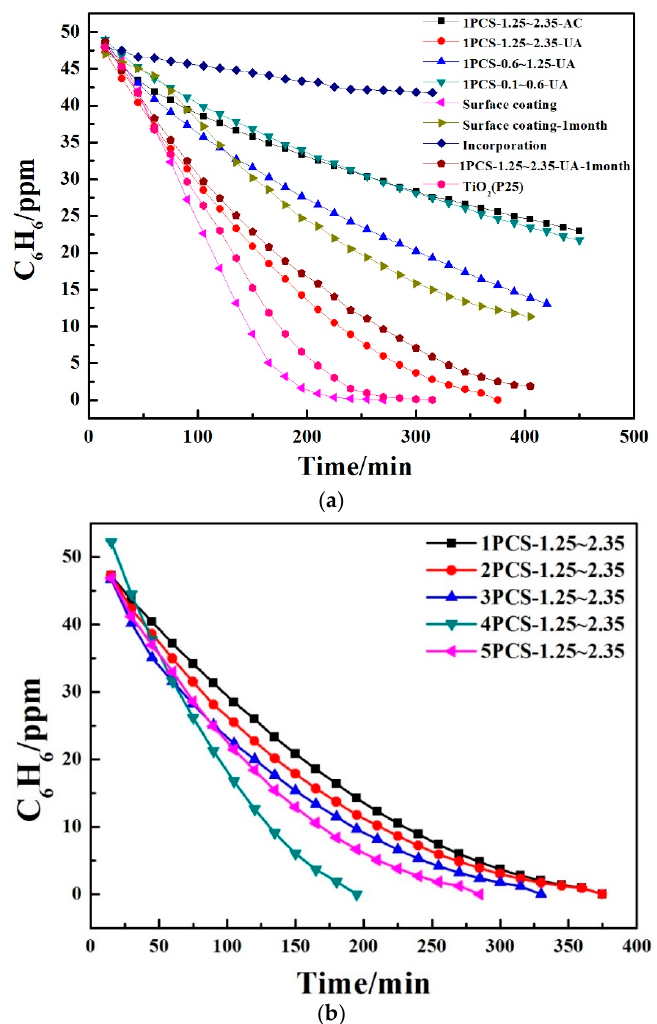
Figure 8. Photocatalytic activity of PCS to benzene; ( a ) 1PCS-n-UA (PCS with ultrasonic activation, n = 0.1~0.6, 0.6~1.25, 1.25~2.35 mm), 1PCS-1.25~2.35-AC (PCS alkali activated), surface coating